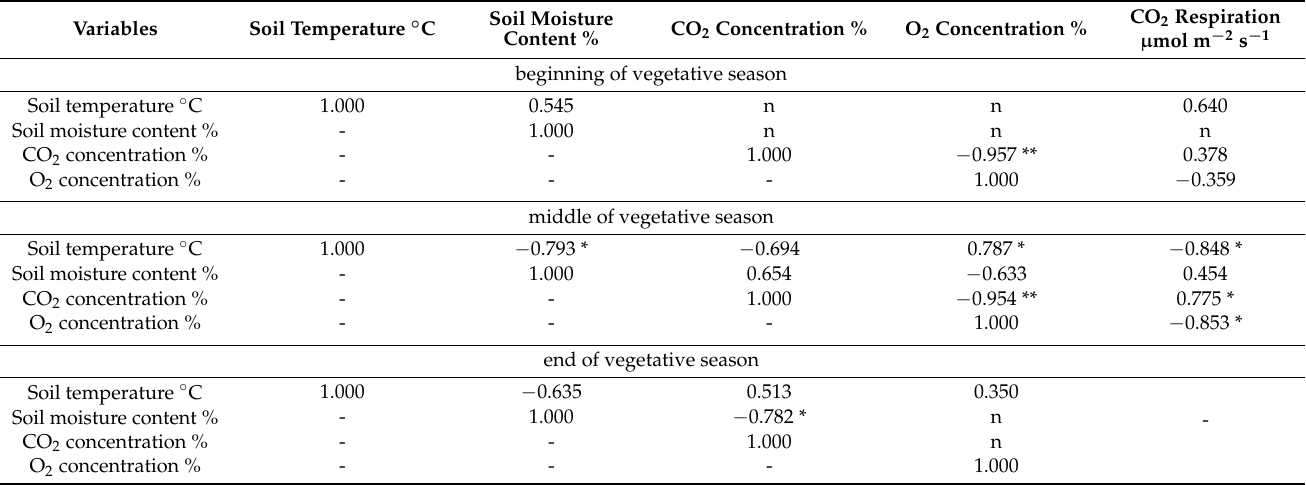
Table 5. Correlations between soil hydrothermal conditions and gasses disposition, 2020.